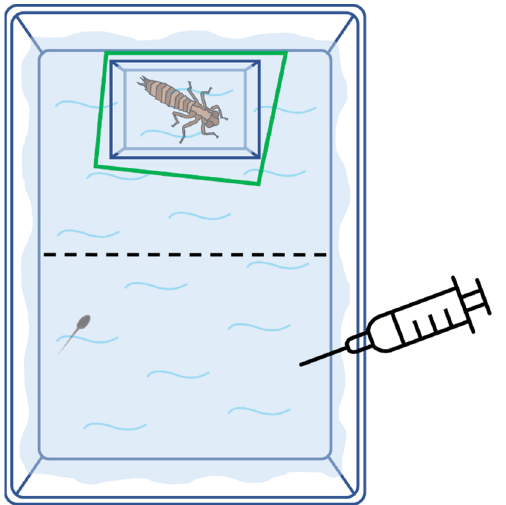
Figure 1. Experimental arena. The predator is located inside a transparent container (top), while the tadpole can freely move in both halves of the arena. After 20 min (pre-stimulus period) from the beginning of the trial, the green polygonal was removed and 8 mL of the olfactory cue (water or predator cue) was added into the arena using a